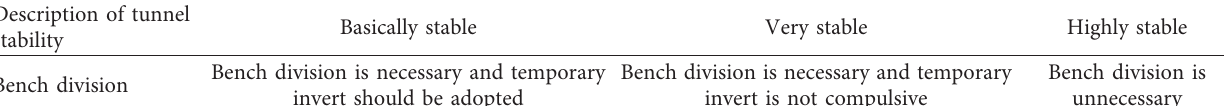
Table 11: Stability index value and bench division of tunnel drift.